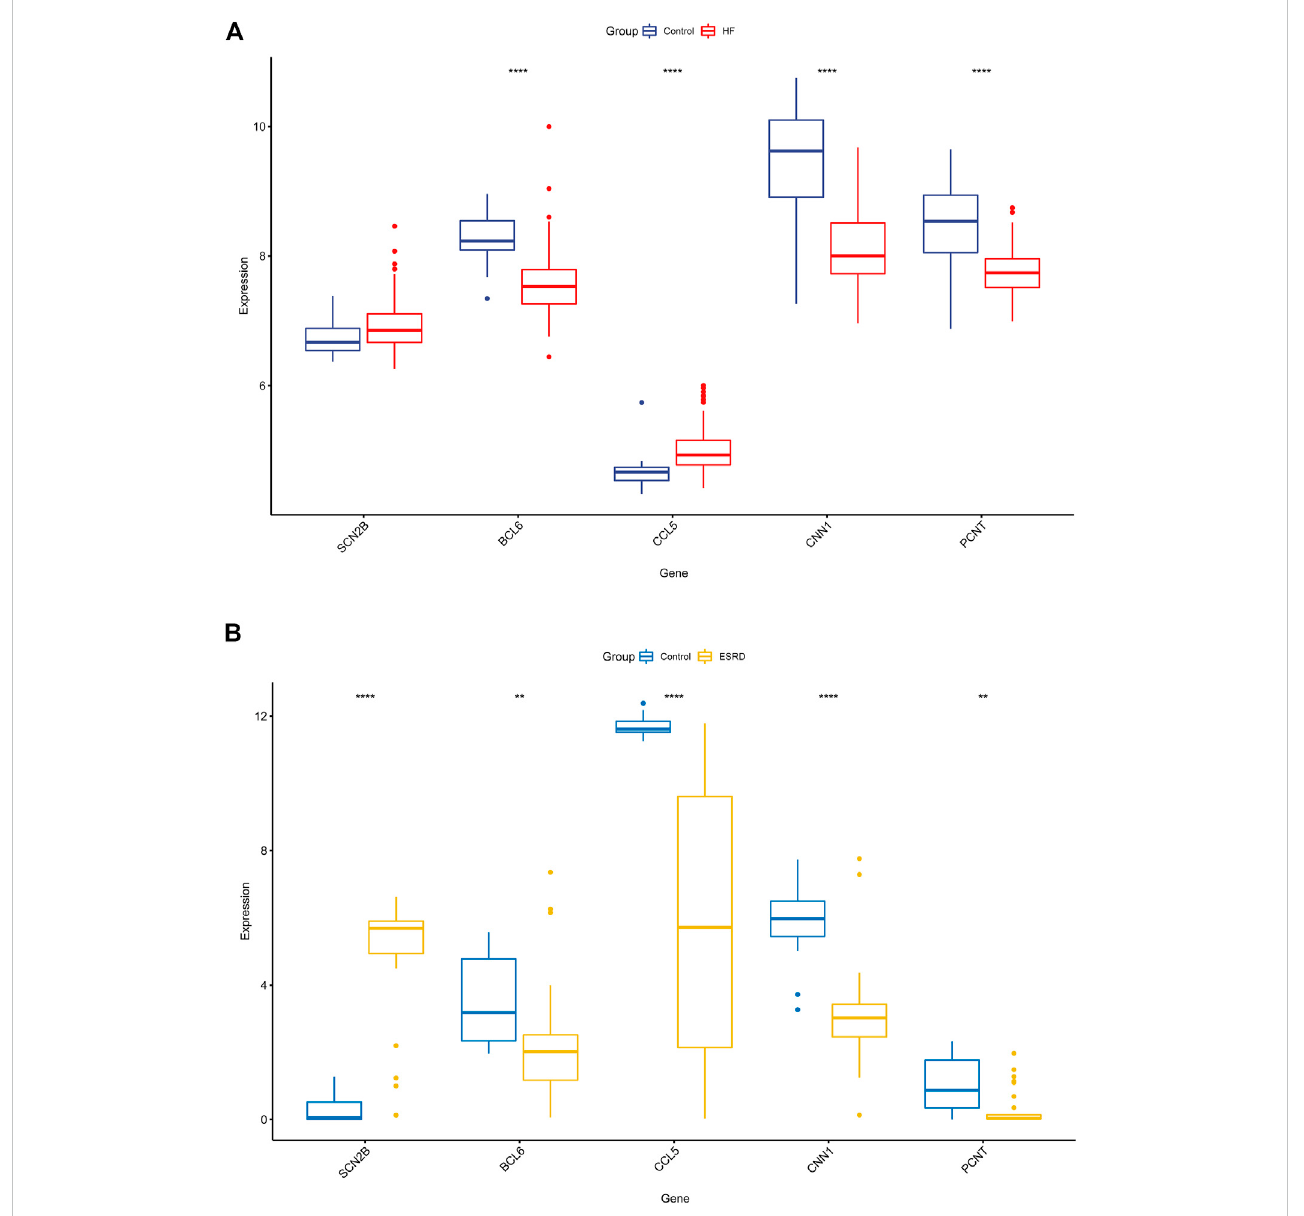
FIGURE 6 Validation of the hub genes in GSE5406 and GSE97709 datasets. (A) Expression levels in GSE5406 datasets. (B) Expression levels of the hub gene in GSE97709 datasets. HF, heart failure; ESRD, end-stage renal disease; p -values are shown as *, p < 0.05; **, p < 0.01; ***, p < 0.001; ns, not signi fi cant.